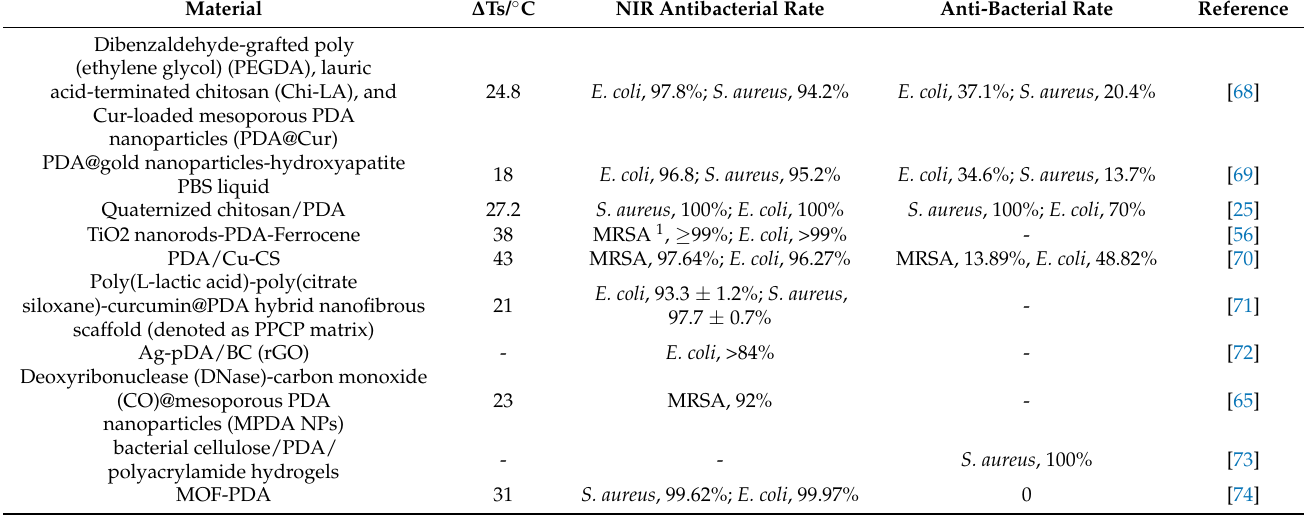
Table 1. NIR heating temperatures and bacteriostatic rates of various materials containing PDA.